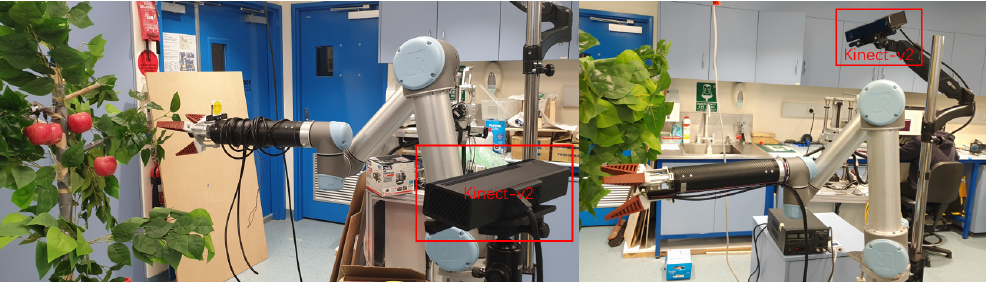
Figure 1. The developing apple harvesting robot. The robot comprises a RGB-D camera for vision sensing. A universal robot arm (UR5) is applied as the